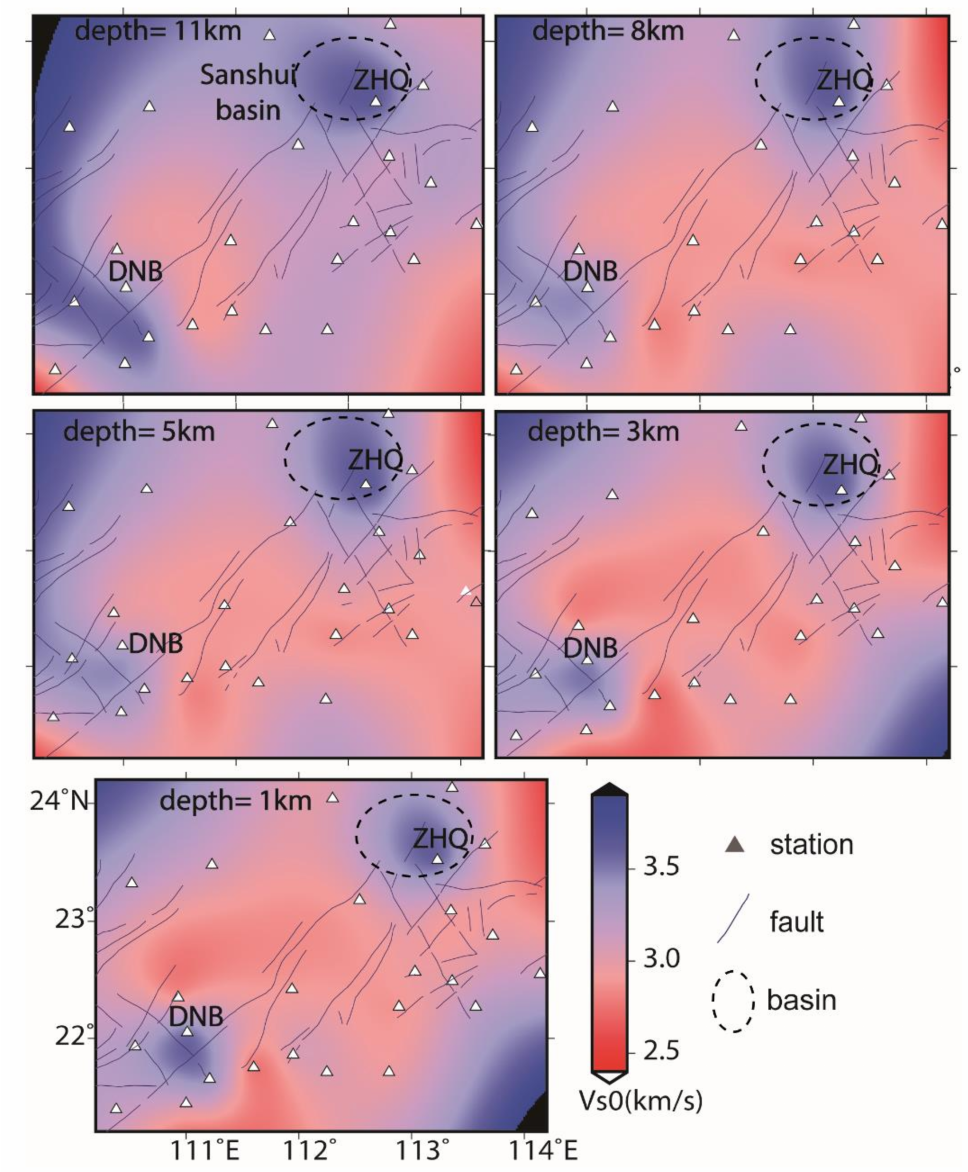
Figure 7. SWV tomographic structure in Yangjiang and its adjacent